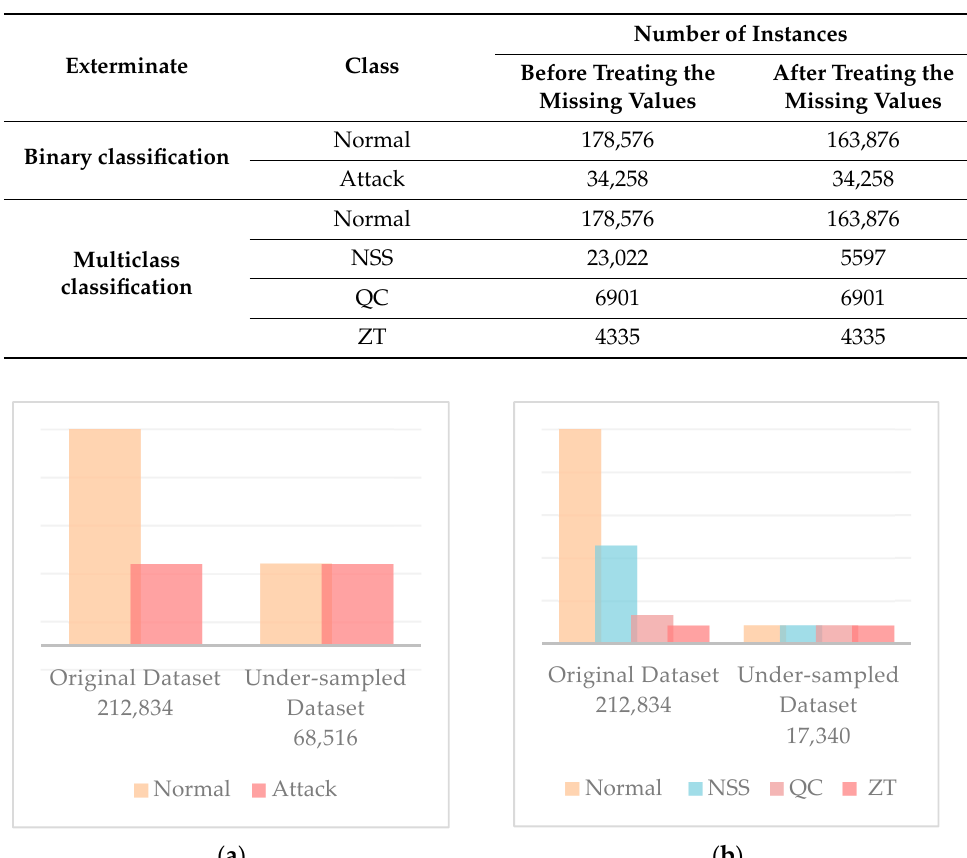
Table 3. Dataset values before and after missing values treatment.